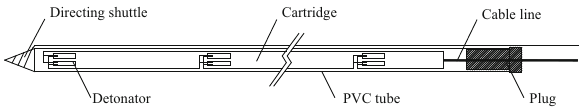
Fig. 3 Charge structure of cumulative blasting (Shang et al.